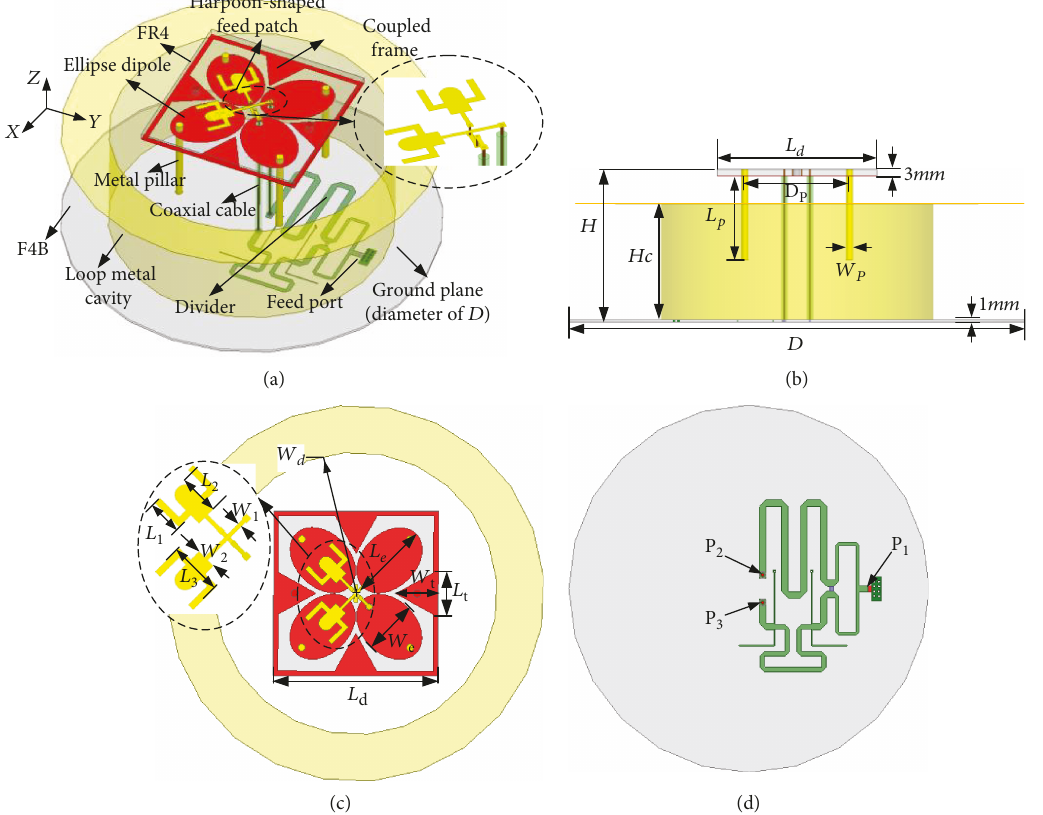
Figure 1: Geometry of the proposed antenna. (a) 3D view. (b) Side view. (c) Top view. (d) Element feed